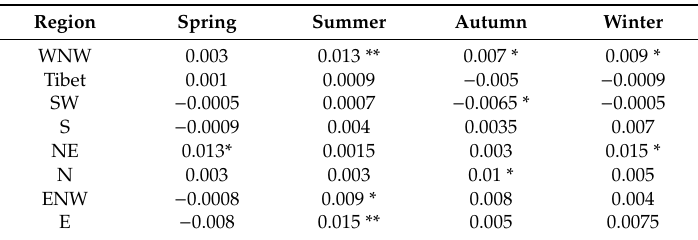
Figure 6. Trends in annual standardized precipitation evapotranspiration index (SPEI) for different regions of China from 1965 to 2017. ( a ) WNW, western Northwest China; ( b ) Tibet, Tibetan Plateau; ( c ) SW, Southwest China; ( d ) S, South China; ( e ) NE, Northeast China; ( f ) N, North China; ( g ) ENW, eastern Northwest China; ( h ) E, East China. The bold black line shows the 5-year moving average value. The blue line shows the trend lines at a 95% confidence interval. p indicated that the significance levels ( p < 0.01 indicated the significant level of 0.01). Table 2. Seasonal trends in the standardized precipitation evapotranspiration index (SPEI) from 1965 to 2017 over di ff erent regions of